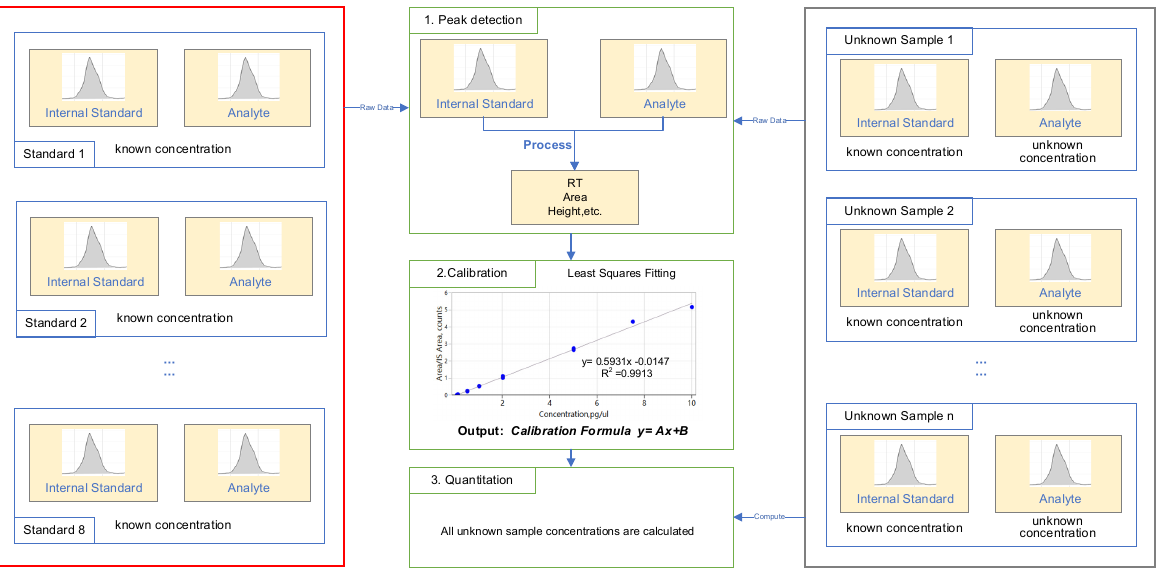
Figure 4. The process of internal standard method for LC-MS/MS quantitative analysis. The left figure shows standard samples containing an IS chromatogram and an analyte chromatogram with a known concentration. The right figure shows unknown samples containing an IS chromatogram with a known concentration and an analyte chromatogram with an unknown concentration. Then, the chromatogram data of these samples are processed by the multi-window-based signal-to-noise ratio estimation algorithm, which contains the steps of raw data denoising, peak identification, peak area calculation and curve fitting to obtain accurate quantitative analysis results of the unknown samples, as shown in the middle figure.